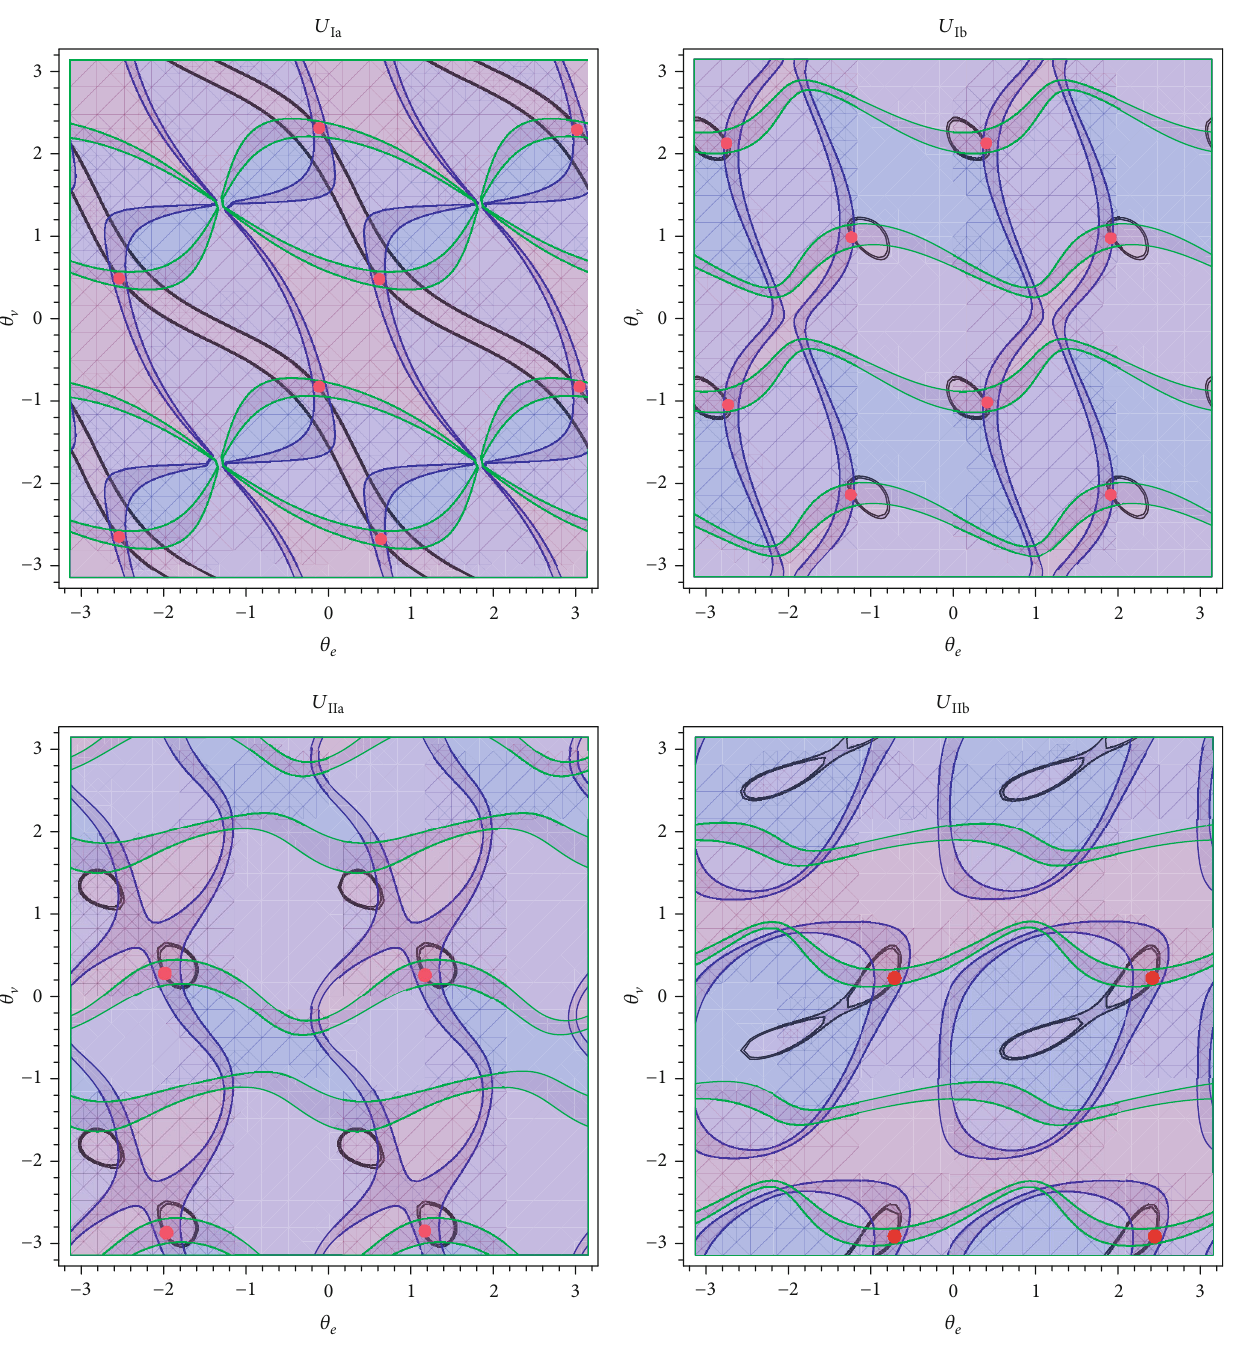
Figure 1: Parameter space for the mixing patterns constrained by the global fi t data [67] at the 3 σ level in the normal mass ordering (NO). The parameter spaces for θ are the strips with blue boundaries, and those for θ 12 almost reduced to black curves. Their intersection areas are signed by the red dots. The parameter spaces in the case of inverted mass ordering (IO) are similar. So they are not shown